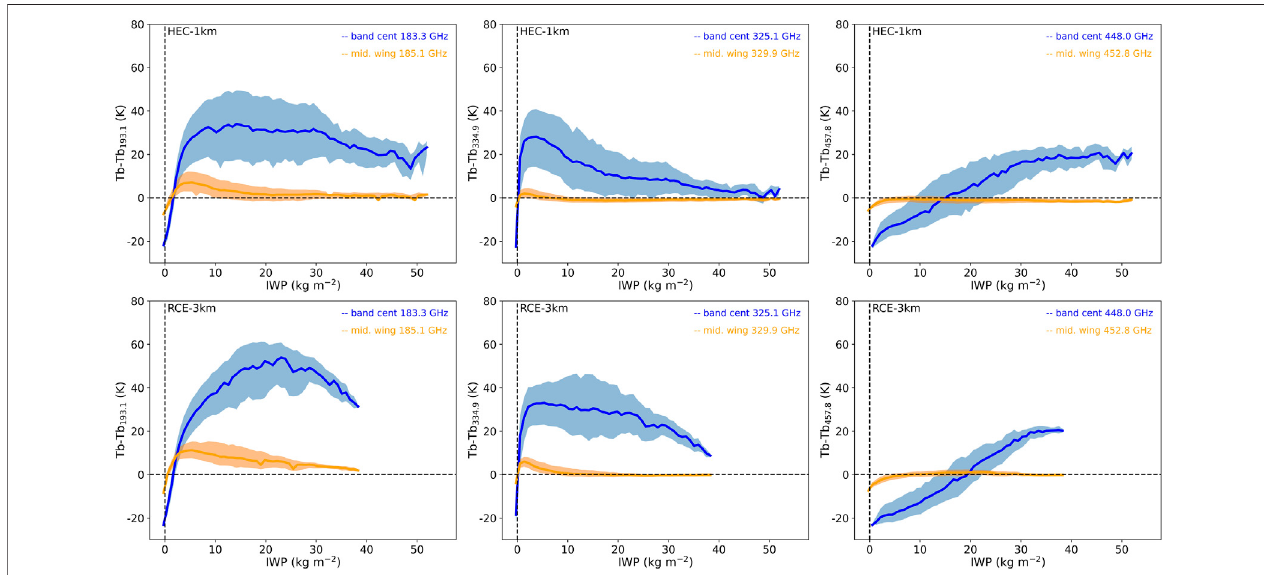
FIGURE 3 | Same as Figure 2 but for the Tb difference between the band center and the wing (Tb center − Tb +10GHz , blue), the mid-wing and the wing (Tb +5GHz − Tb +10GHz ,